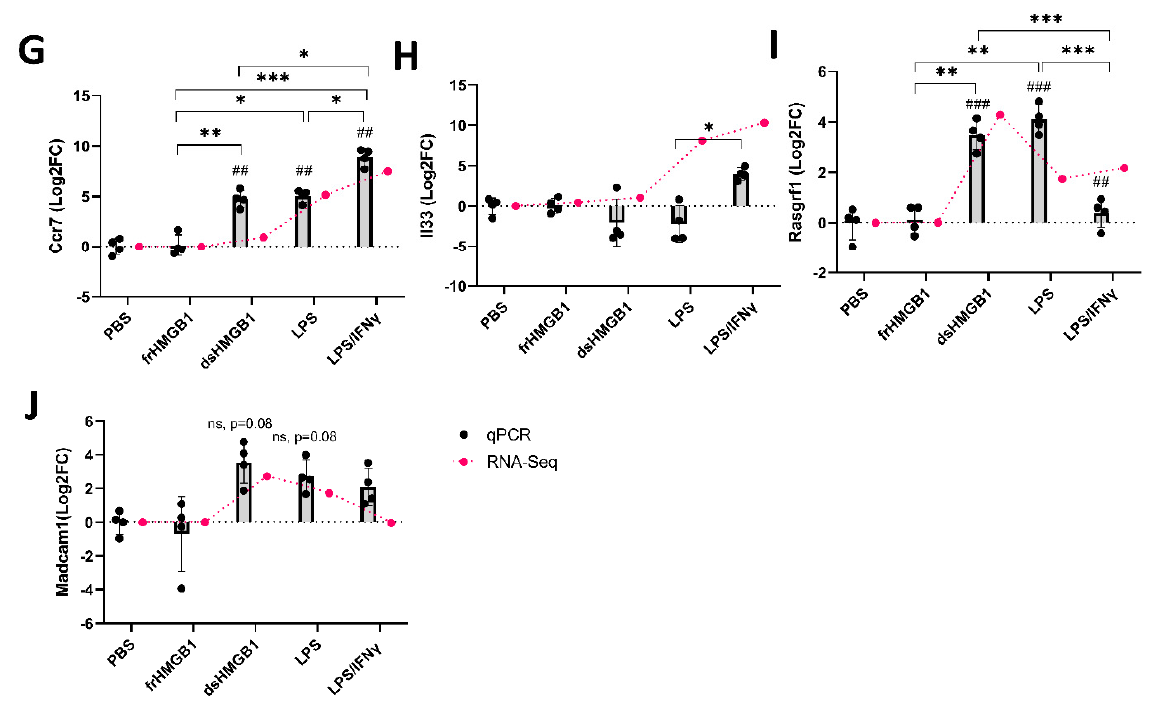
Figure 3. qPCR validation of the featured genes identified by RNA-Seq. Expression of Il12b ( A ), Cxcl9 ( B ), Cnr2 ( C ), Lrrc17 ( D ), Ikzf4 ( E ), Hamp ( F ), Ccr17 ( G ), Il33 ( H ), Rasgrf1 ( I ), Madcam1 ( J ) were determined using qPCR in BMDMs stimulated for 24 h by frHMGB1, dsHMGB1, LPS and LPS/IFN γ (M1), n = 4 mice, 2 replicates/mouse/condition. Gene expression is represented as Log2FoldChange (Log2FC) relative to the mean of the PBS group, and the scale bars represent the standard deviations (SD). Red dots represent the RNA-Seq results. Statistical comparisons were performed using RM-one way ANOVA with Turkey’s multiple comparisons test on data that are normally distributed or using Friedman test with Dunn’s multiple comparisons on data that are not normally distributed. # = significant comparing with PBS control; * = significant comparing between two treatment groups. */#, p < 0.05; **/##, p < 0.01; ***/###, p < 0.001; ****/####, p < 0.0001.